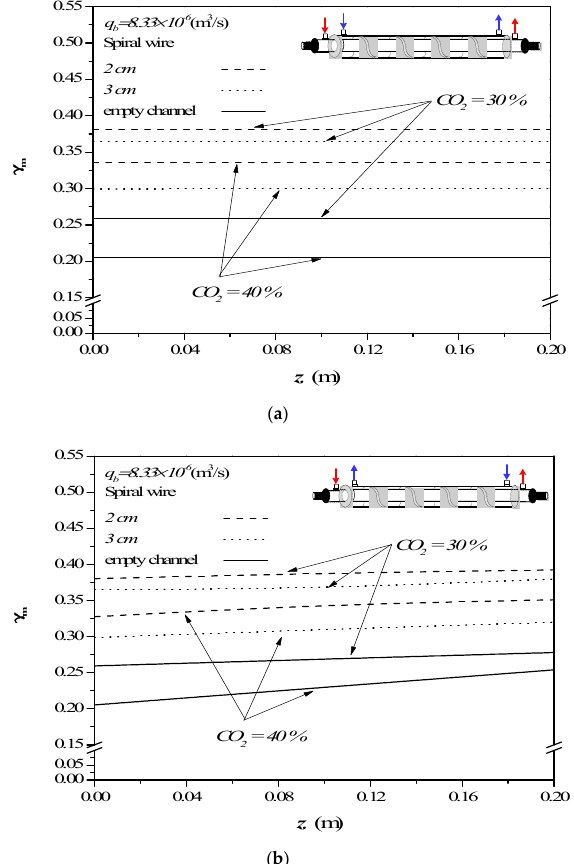
Figure 9. Effects of spiral-wire pitches and CO 2 concentration on m γ . ( a ) Concurrent-flow operations; ( b ) Countercurrent-flow operations. The turbulence intensity promotion by inserting spiral wires in both concurrent- and countercurrent-flow operations aimed to shrink concentration polarization layers and diminish the mass-transfer resistance as well, whereby the absorption flux is enhanced. The results show that the value of m γ for the 2 cm pitch of the spiral wired channel is larger than those of the 3 cm pitch of the spiral wired channel, as well as the module with an empty channel, which means the operating 2 cm pitch of the spiral wired channel resulted in a lesser mass-transfer resistance for CO 2 absorption. Restated, inserting spiral wires in the flow channel is a positive influence on the eddy promotion, and the smaller